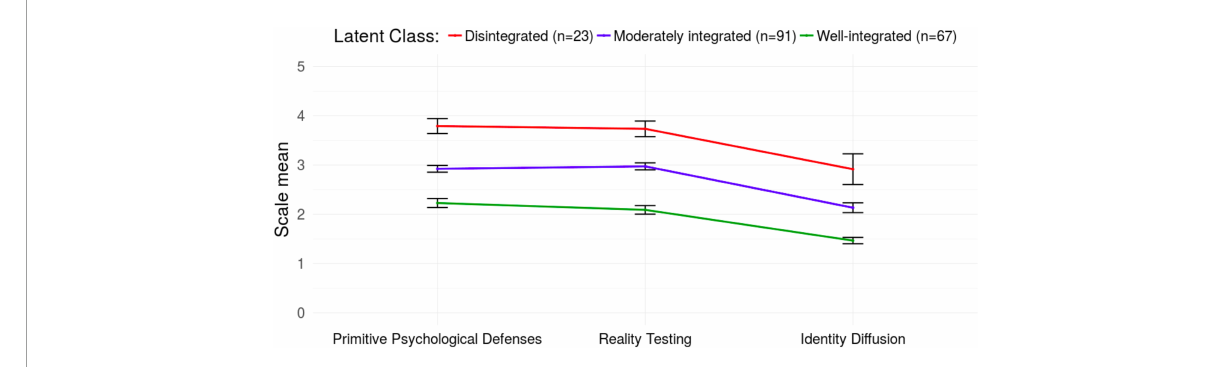
FIGURE1 Latent class means on the three primary factors of the Inventory of Personality Organization (IPO) with 95% confidence intervals.